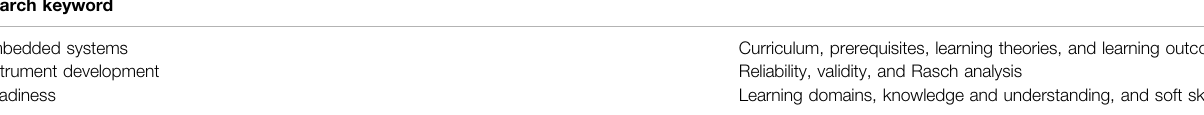
TABLE 4 | Search keywords. Search keyword